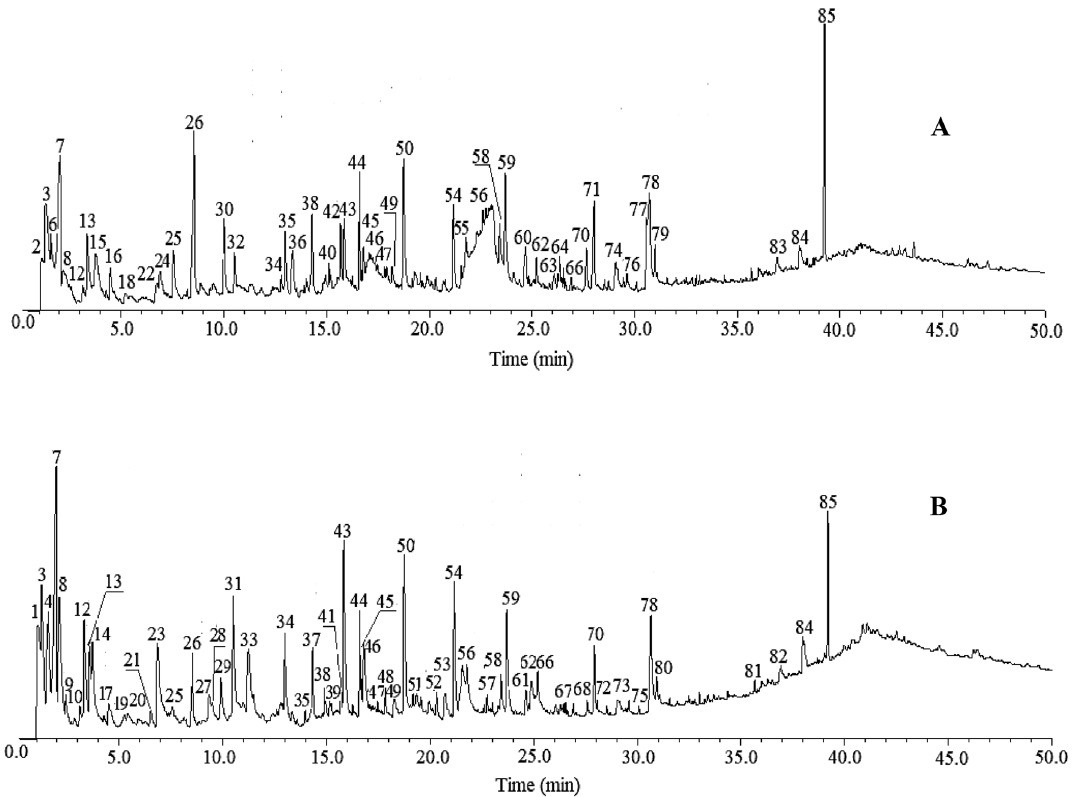
Figure 1. Py–GC/MS chromatogram of the sapwood ( A ) and heartwood ( B ) of the Tectona grandis